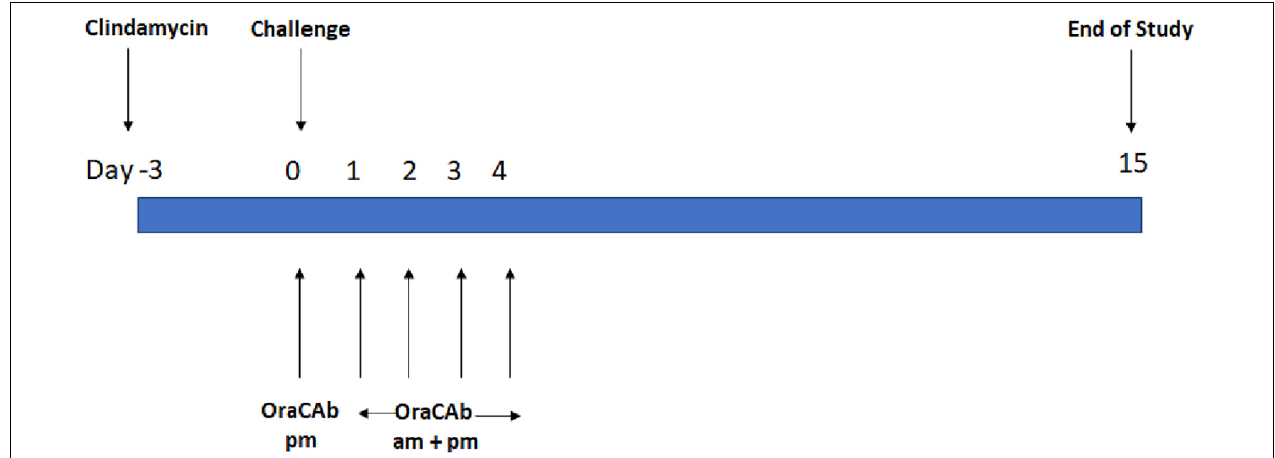
FIGURE 1 | Treatment design of the in vivo hamster model of CDI. Each experiment contains sentinel group (x4) that receive clindamycin only and an untreated control group (x10) receiving clindamycin and challenge with C. difficile .